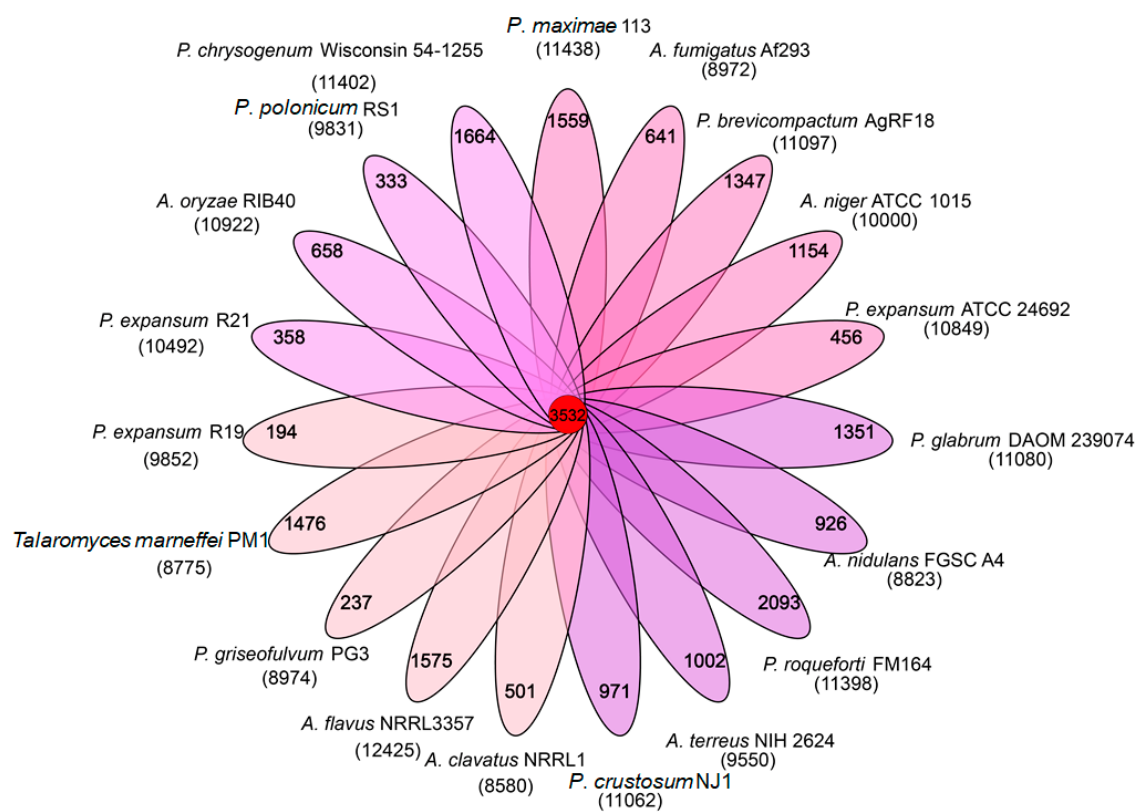
Figure 2. A Venn diagram of the homologous genes from eighteen genomes of Penicillium and Aspergillus species. Twelve Penicillium and seven Aspergillus strains were used in the analysis.